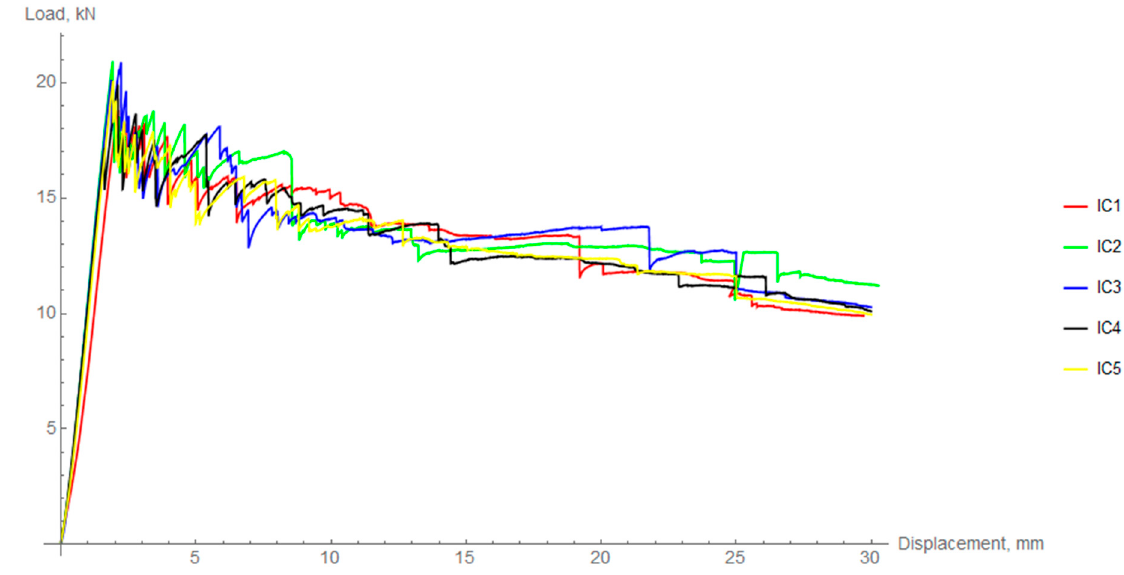
Figure 12. Load-displacement curves for radial compression of intermediately cooled (IC) rings.